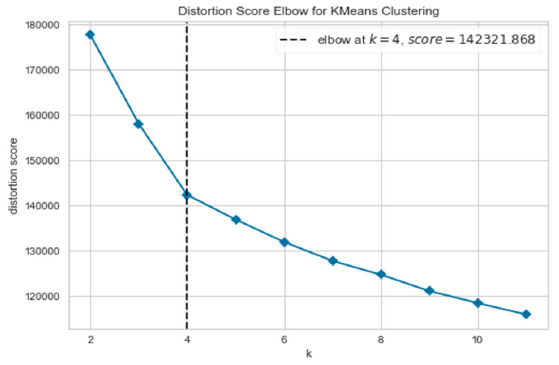
Fig. 8. Distortion Score Elbow for K-Means